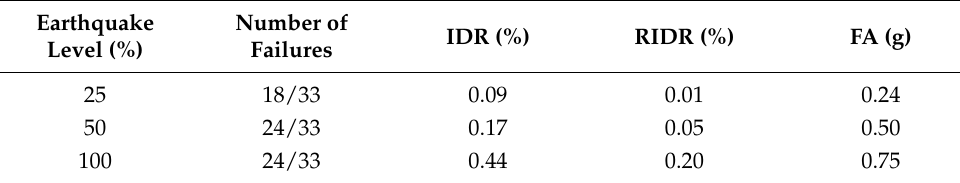
Table 7. Number of failures and peak IDR, RDIR, FA values-case (ii): flexural hinges.